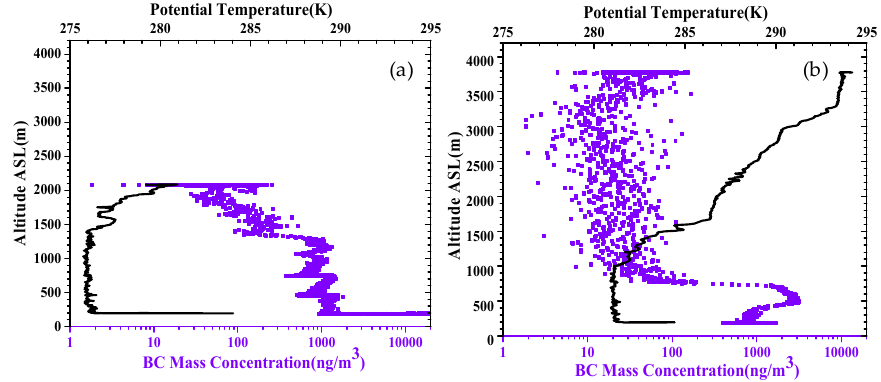
Figure 5. Potential temperature (black solid line) and black carbon aerosol (BC) mass concentration (purple solid squares) detected by the two flights in October 2016: ( a ) 20 October 2016; ( b ) 25 October 2016.